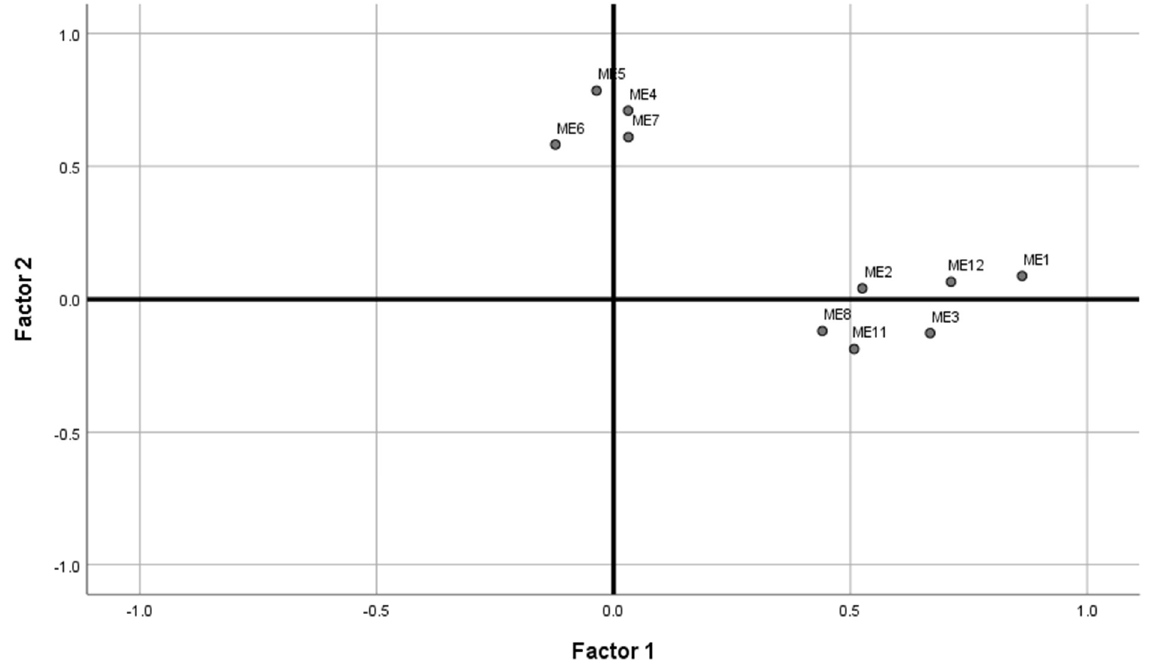
Figure A1. Component plot in rotated space. Table A2. The factor loading of each item after rotation.